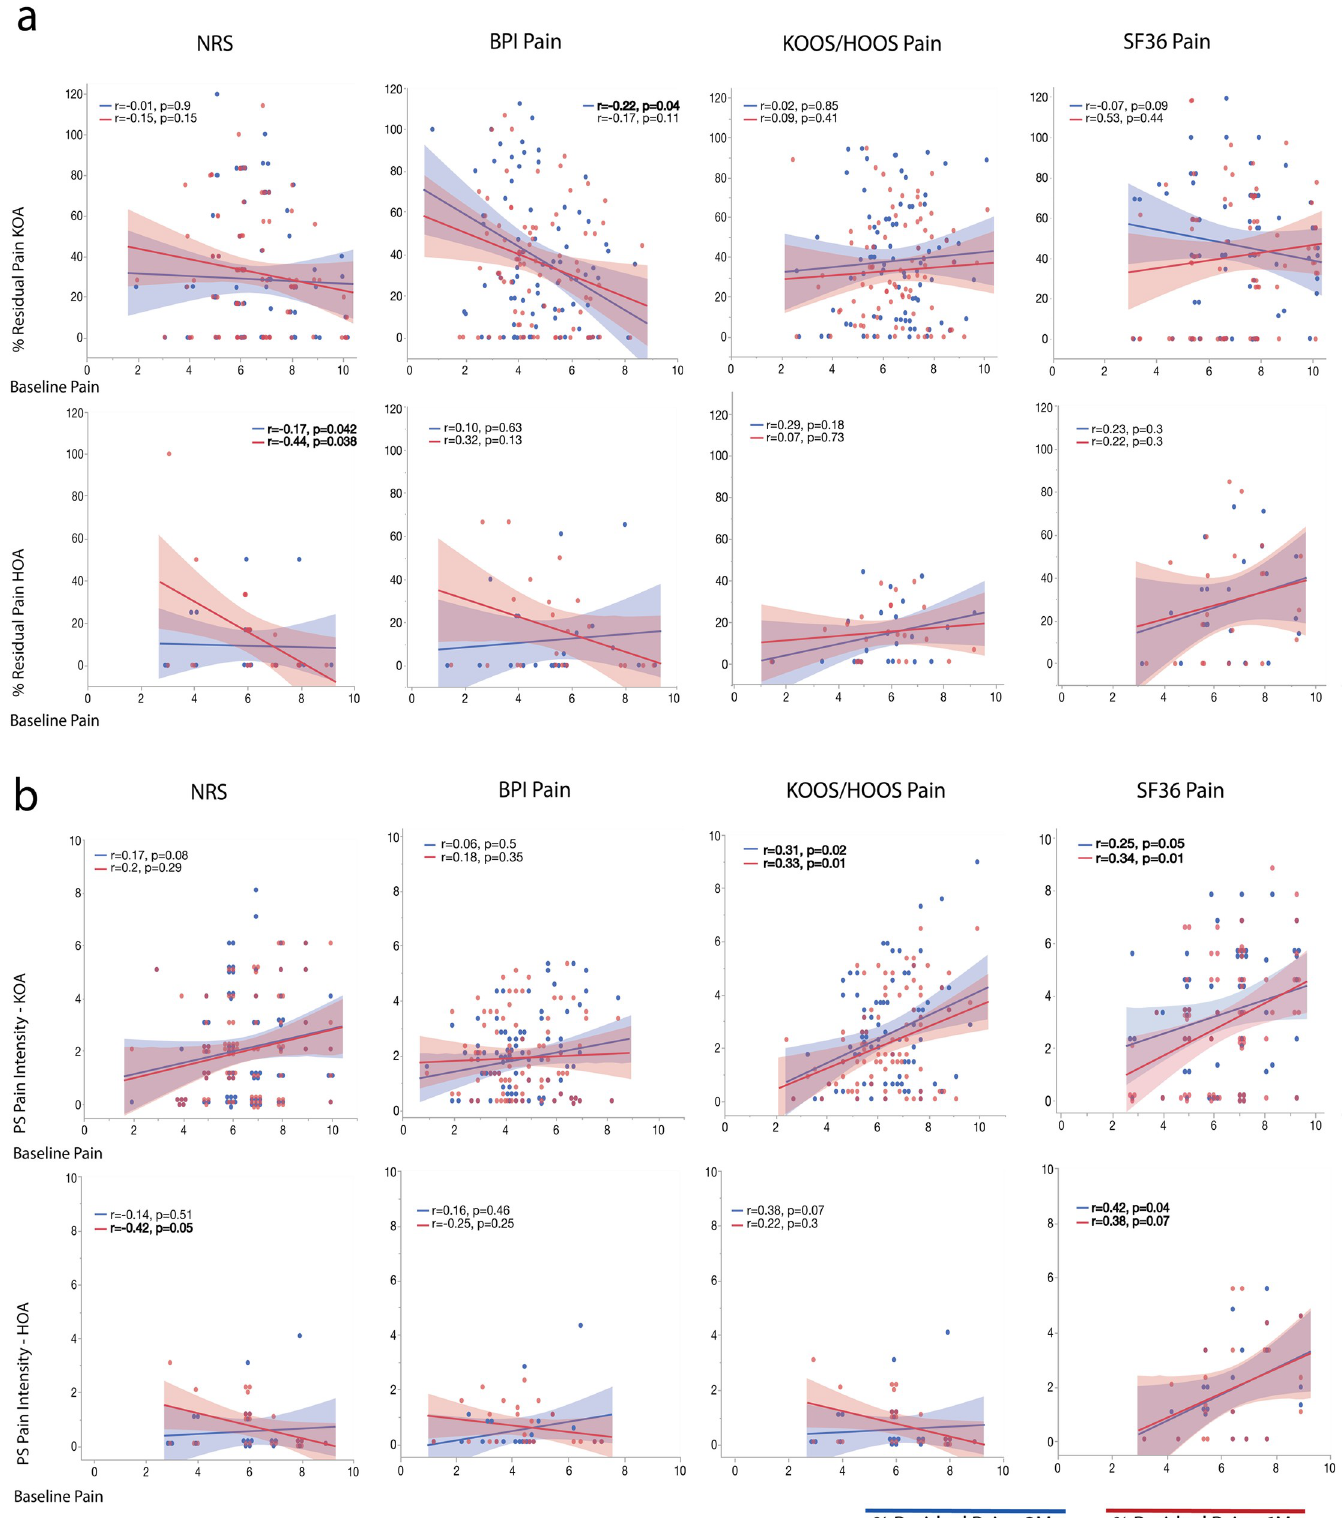
Fig 3. Influence of baseline pain levels on post-surgical residual pain. The scatterplots depict patients’ percentage residual pain after surgery (% residual pain, where 100% = no change from pre-surgical levels, 0% = full recovery) (a), and post-surgery absolute pain intensity (b) relative to pre-surgical levels, as a function of pre-